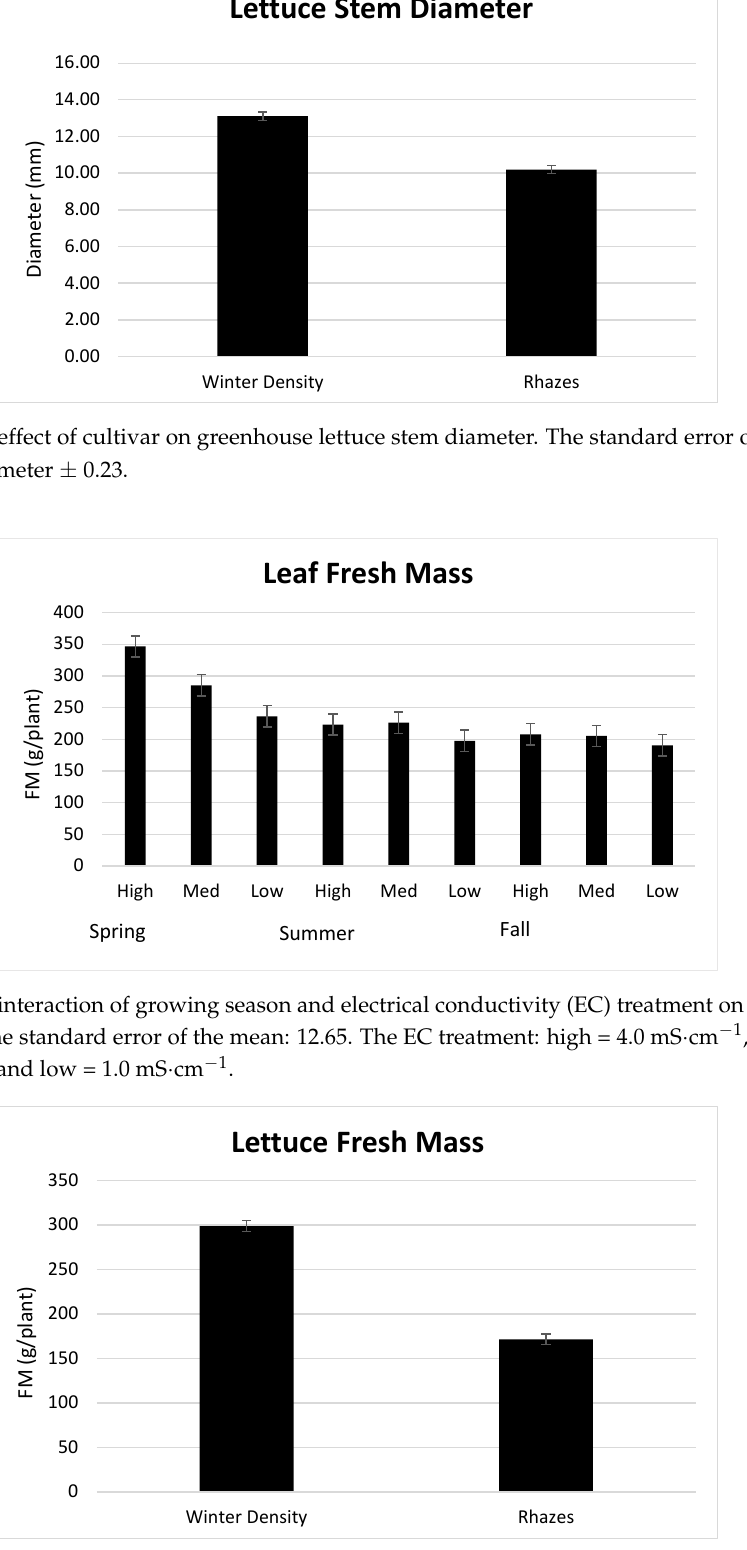
Figure 5. The effect of cultivar on greenhouse lettuce fresh mass. The standard error of the mean was: lettuce fresh mass ± 5.96.